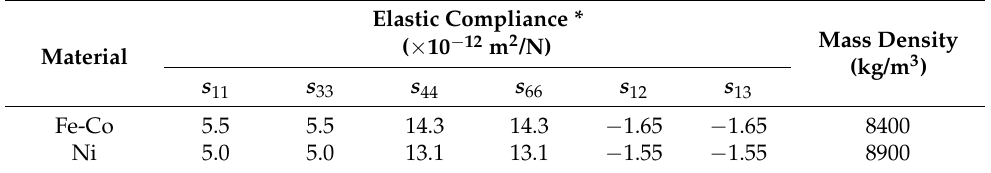
Figure 1. Finite element model of the Fe-Co/Ni clad plate. ( a ) geometry and ( b ) finite element mesh. Table 2. Elastic compliance and mass density of the Fe-Co and Ni layer.